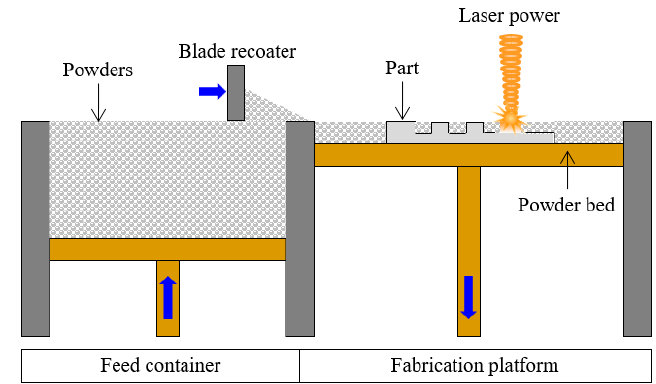
Figure 2. Schematic of BP printing process in